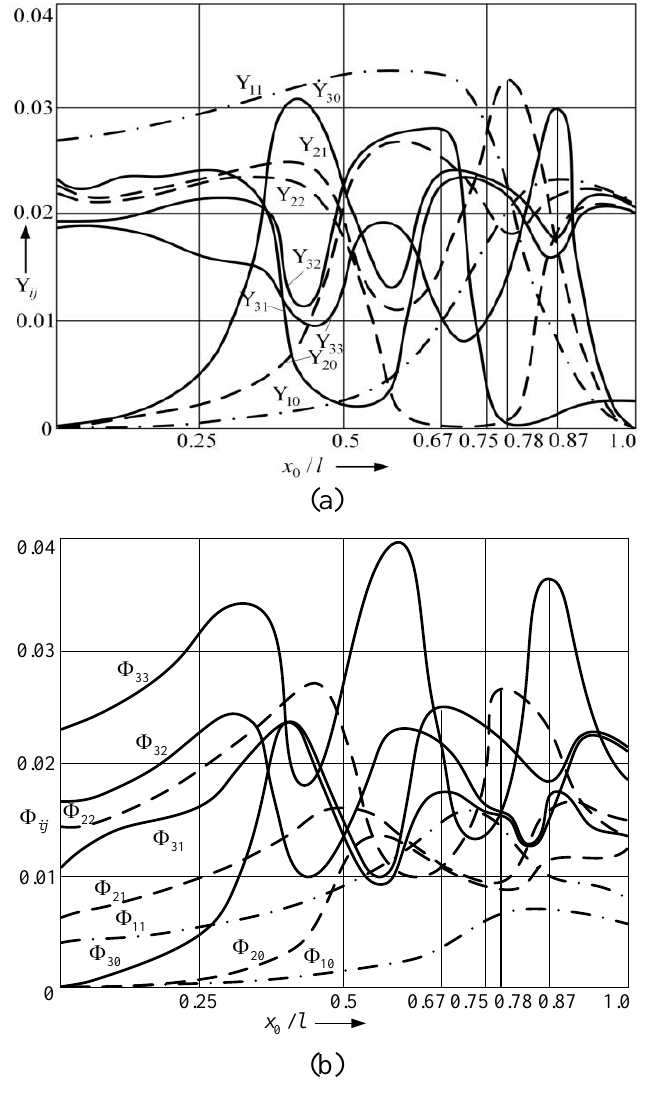
Figure 7. Dependence of maximum amplitudes of the flexural (Y modes on the position of the support: (a) flexural, (b) rotational. Index i —number of vibration mode, j —sequence number of the maximum amplitude point with respect to the anchor